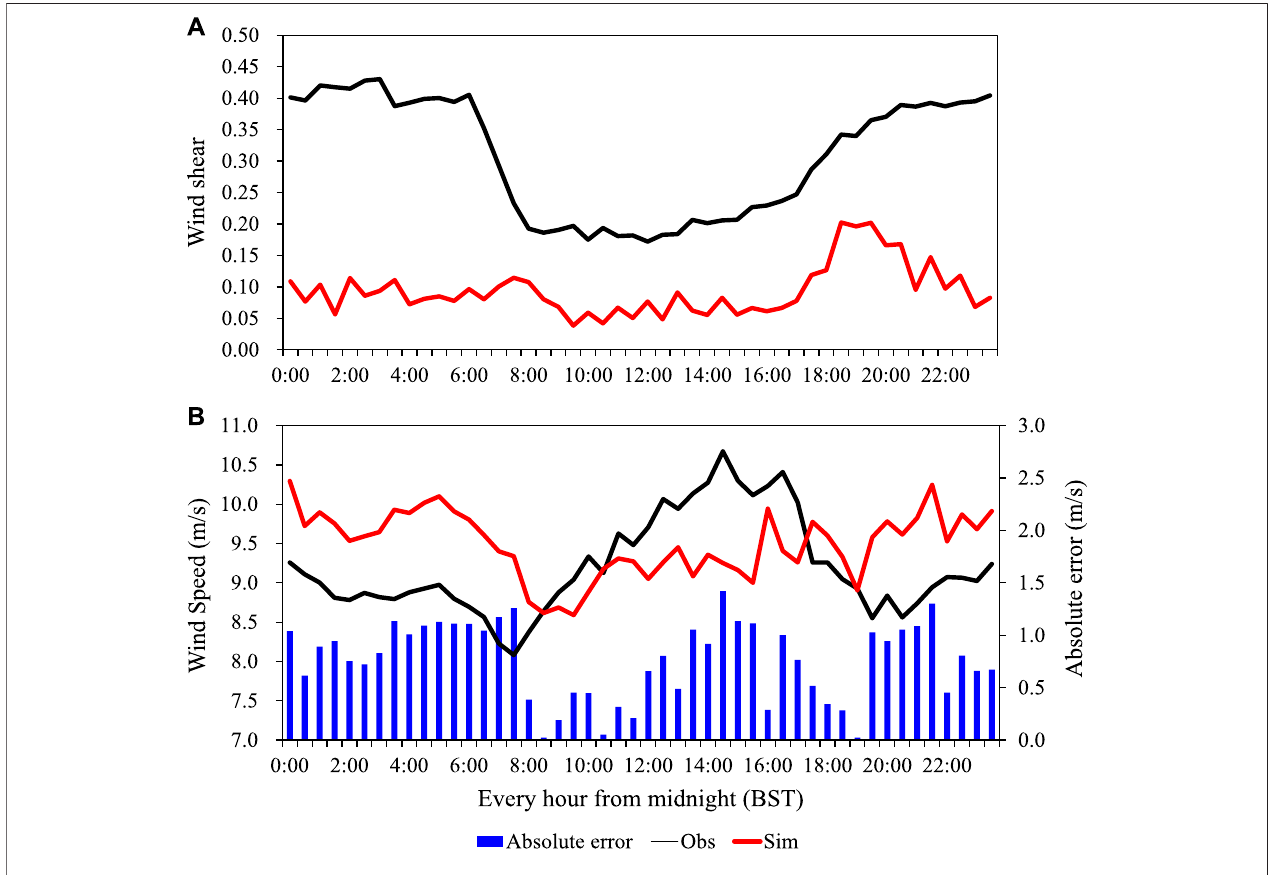
FIGURE 6 | Comparisons of the daily variations of (A) near-surface wind shear and (B) near-surface wind speed between observations and simulations in YSU scheme. Theblue rectangle denotes the absolute errorofsimulatednear-surface wind speed. In (B) , the y -axis on theleft isthe near-surface wind speed, and the y -axis on the right represents the absolute error of simulated near-surface wind